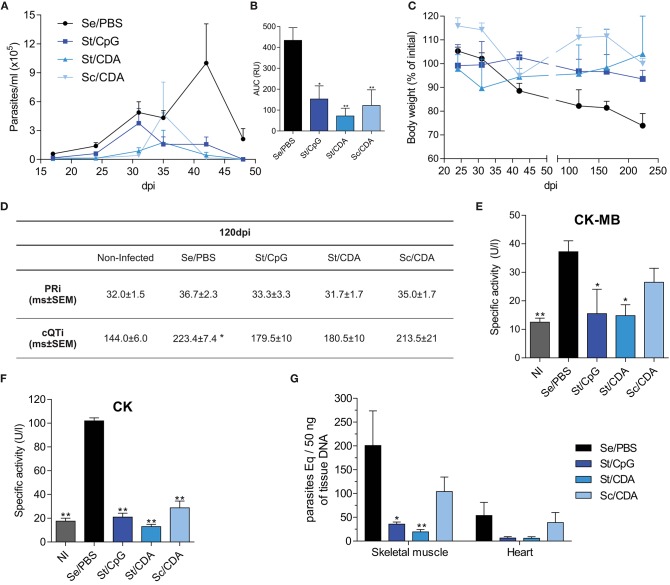
Assessment of vaccine efficacy during parasitic chronic infection with a vaccine unrelated strain. Male C3H mice were vaccinated and 30 days after last dose were infected with blood trypomastigotes of T. cruzi K-98 strain. (A) Parasitemia. (B) Area under the curve (AUC) of parasitemia. RU, relative units **p < 0.01, *p < 0.05 differences were calculated with respect to the Se/PBS control group, one-way ANOVA + Bonferroni post-hoc test. (C) Weight loss. Results are expressed as percentage with respect to pre-infection. (D) Electrocardiogram parameters: corrected QT interval (cQTi) and PR interval (PRi), *p < 0.05 against non-infected mice, one-way ANOVA + Dunn's post-test. Serum activity of cardiomyopathy-associated enzymes. (E) Creatine kinase MB isoform (CK-MB). (F) Creatine kinase (CK), from immunized infected mice. NI, non-infected. *p < 0.05, **p < 0.01 compared to Se/PBS group, bars indicate significant differences, p < 0.05, between the indicated groups, one-way ANOVA + Dunnett's post-test. (G) Parasite load by qPCR in target tissues, *p < 0.05, **p < 0.01 compared to Se/PBS group, two-way ANOVA + Dunnett's post-test. n = 3–7 mice per group. All results are representative of at least two independent experiments.